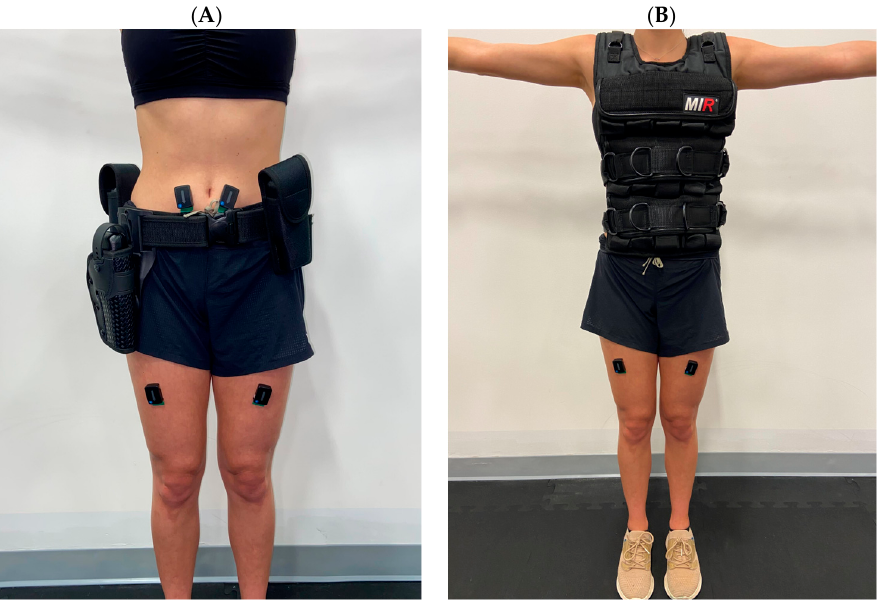
Figure 1. Representative image of participant wearing law enforcement ( A ) duty belt and ( B ) tactical vest.